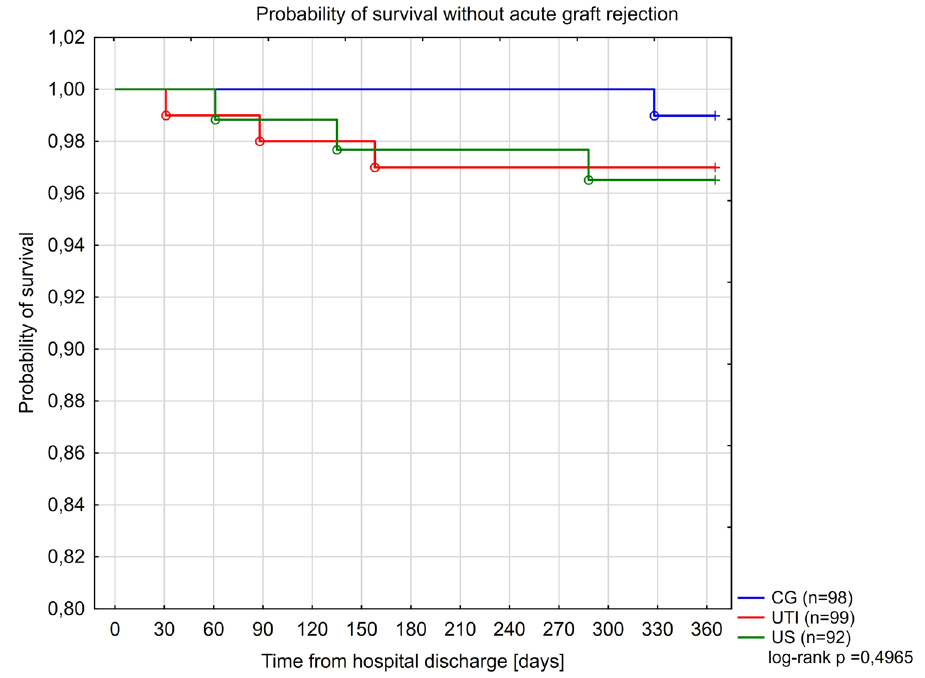
Figure 5. Kaplan Meier curves for survival without acute graft rejection in the study groups.